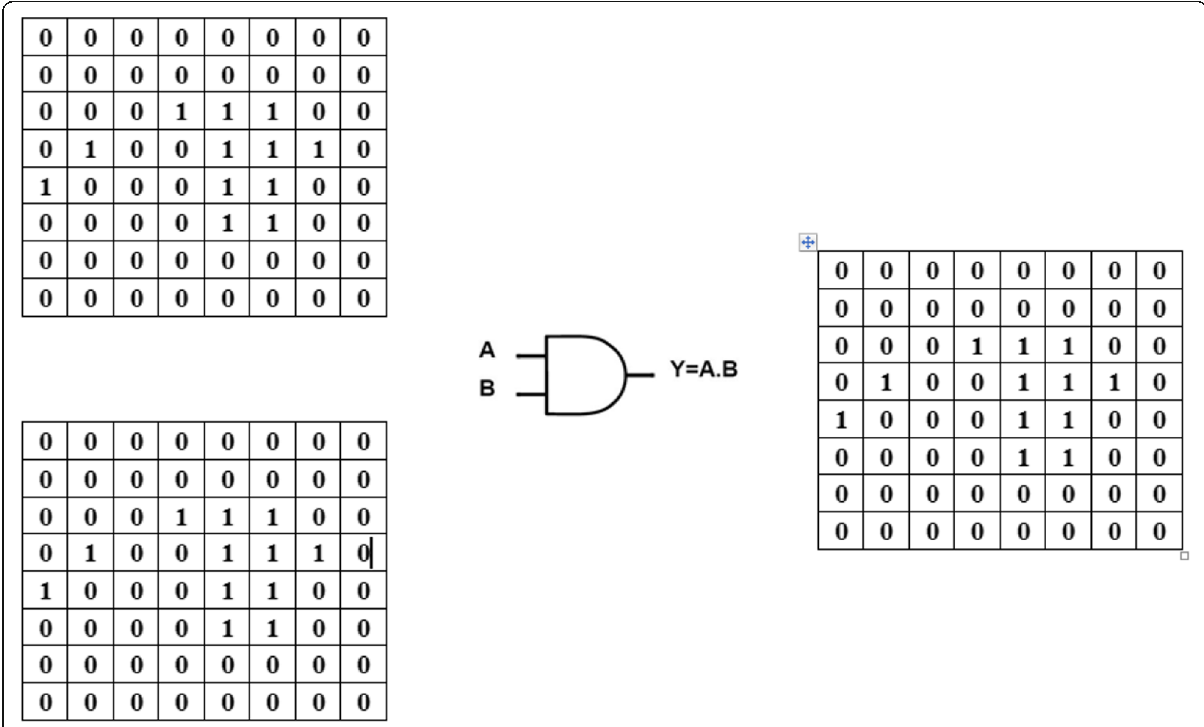
Fig. 6 Logical AND operation performed on two binary